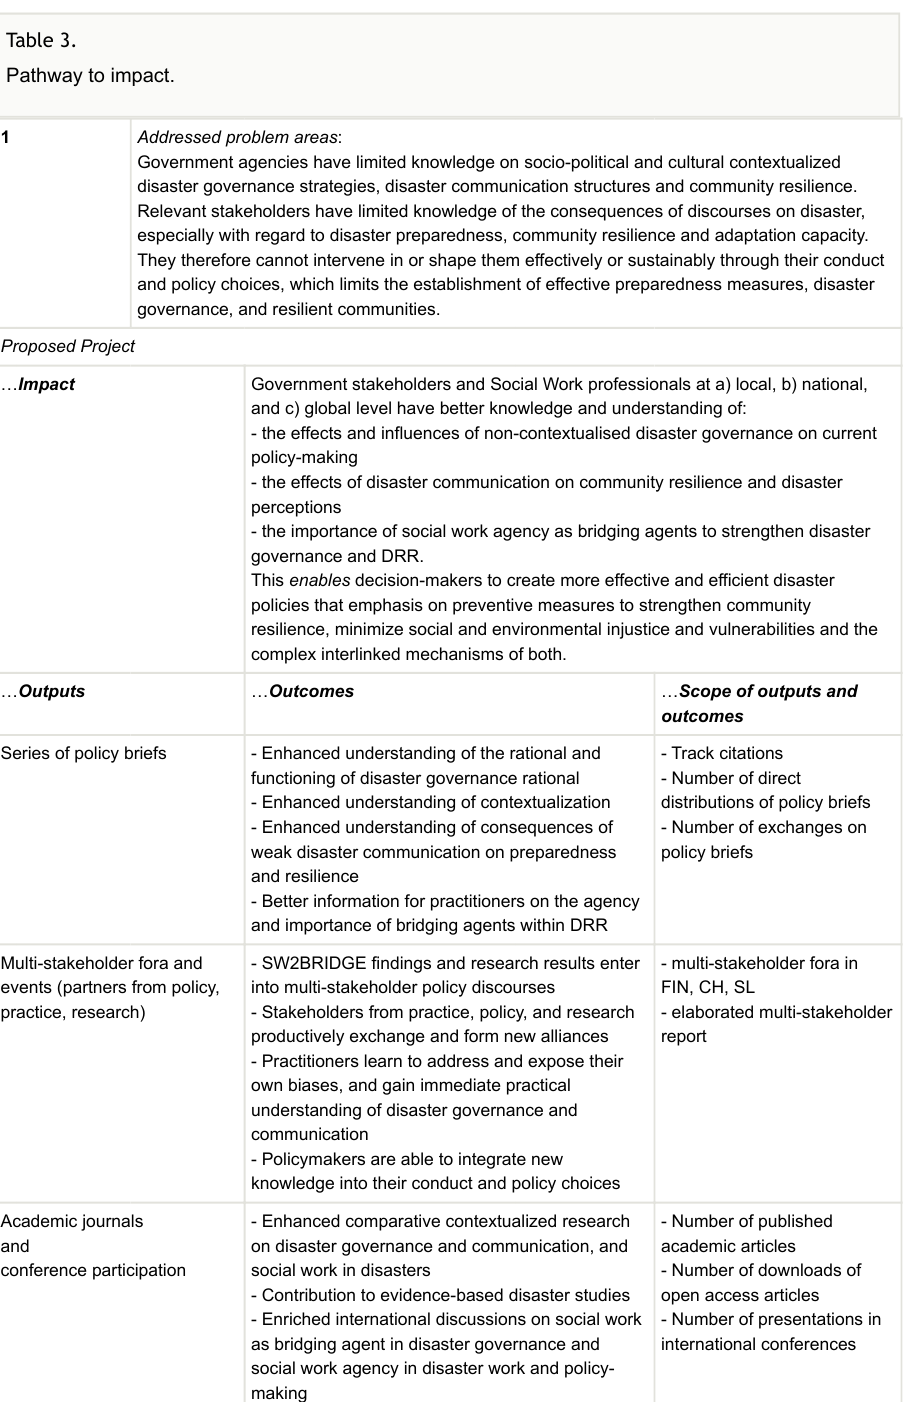
Situating social work within disaster governance. Assessing the agency